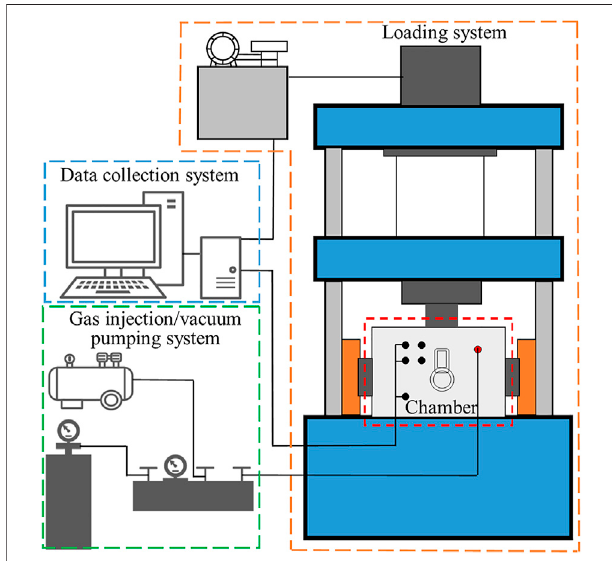
FIGURE 2 | Schematic of the triaxial coal and gas outburst simulation test